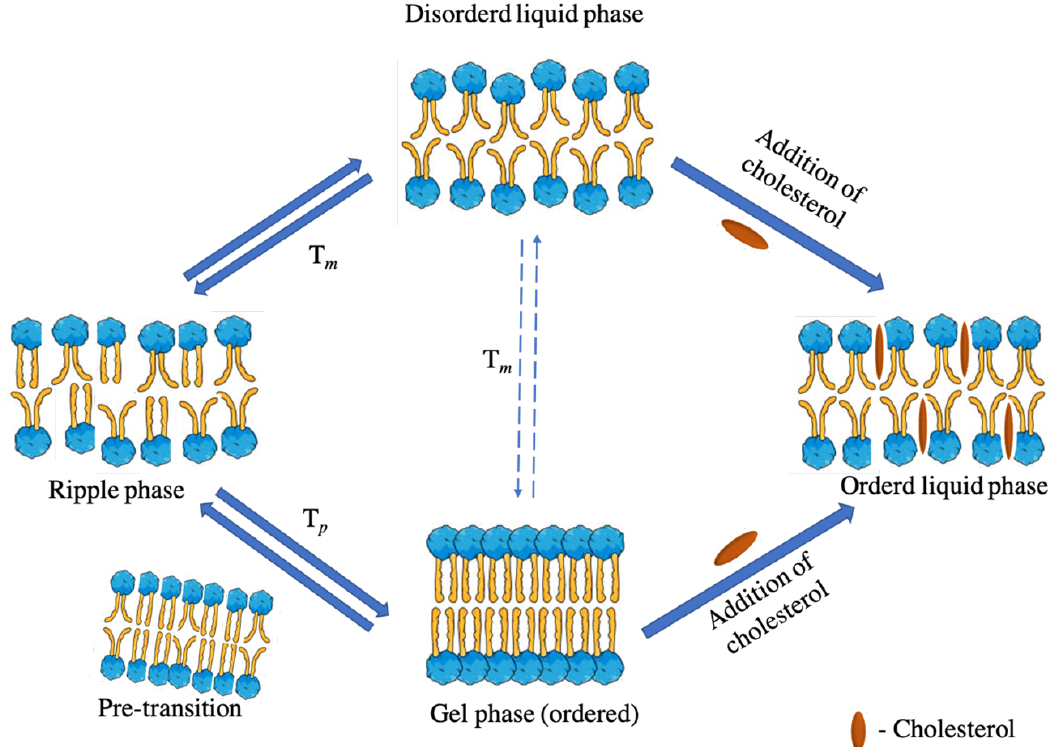
Figure 5. An illustration of the thermotropic behavior of hydrated phospholipids in both phase transition temperature ( T m ) and pre-transition temperature ( T p ).